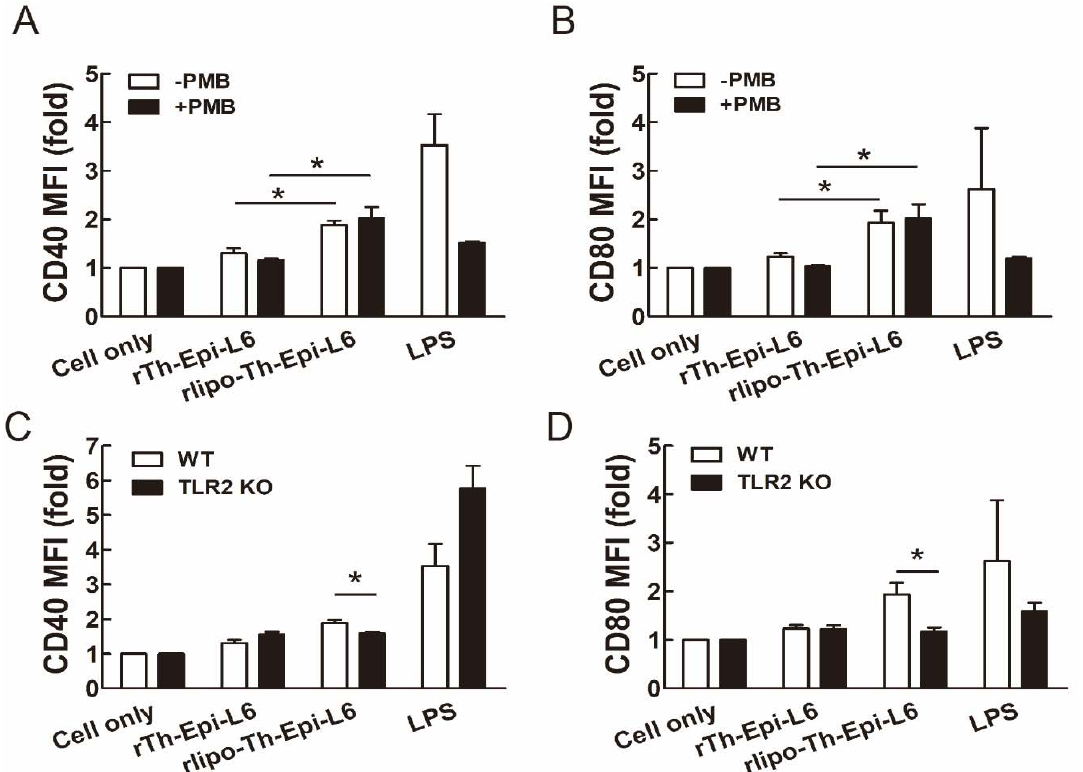
Figure 2. rLipo-Th-Epi-L6 activates bone marrow-derived dendritic cells (BM-DCs). ( A , B ) BM-DCs from wild-type mice were cultured in medium supplemented with rTh-Epi-L6 (50 nM), rlipo-Th-Epi-L6 (50 nM), or LPS (0.1 µ g / mL), in the presence or absence of polymyxin B (PMB; 30 µ g / mL). After a 24-h incubation, the expression of the DC surface markers CD40 ( A ) and CD80 ( B ) was analyzed using flow cytometry. The experiments were performed in triplicate, and the mean fluorescence intensity (MFI) of the cells cultured in medium alone was defined as 1. ( C , D ) BM-DCs isolated from wild-type and TLR2 knockout (TLR2 KO) mice were cultured in medium supplemented with rTh-Epi-L6 (50 nM), rlipo-Th-Epi-L6 (50 nM) or LPS (0.1 µ g / mL), and then DC surface markers CD40 ( C ) and CD80 ( D ) were analyzed using flow cytometry. Data are presented as the means ± SEM of at least three independent experiments. * p < 0.05 by t ‐ test.